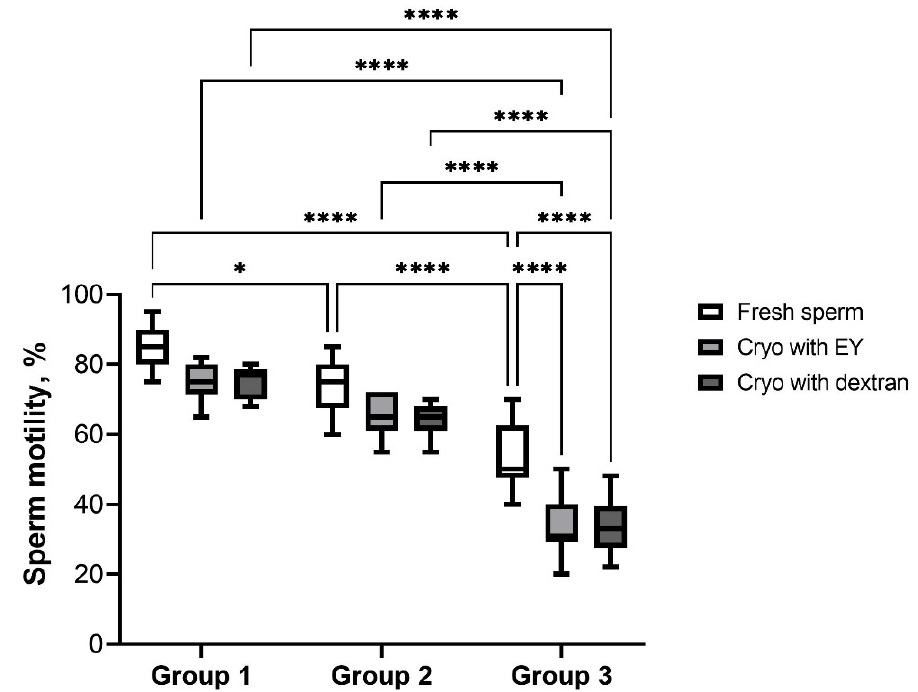
Figure 3. Total motility of spermatozoa of dogs of different ages after cryopreservation with two different extenders. *— p < 0.05, ****— p < 0.0001. The percentage of progressive motile spermatozoa decreased in dogs of group 2 and declined dramatically after cryopreservation of spermatozoa of group 3 regardless of the use of an extender (Table 3). VCL, VAP, and VSL decreased in fresh sperm of dogs older than 7 years and in cryopreserved sperm of dogs older than 3 years regardless of the use of an extender. The parameters of ALH and STR did not change significantly in all study groups. Table 3. Parameters of sperm motility measured by